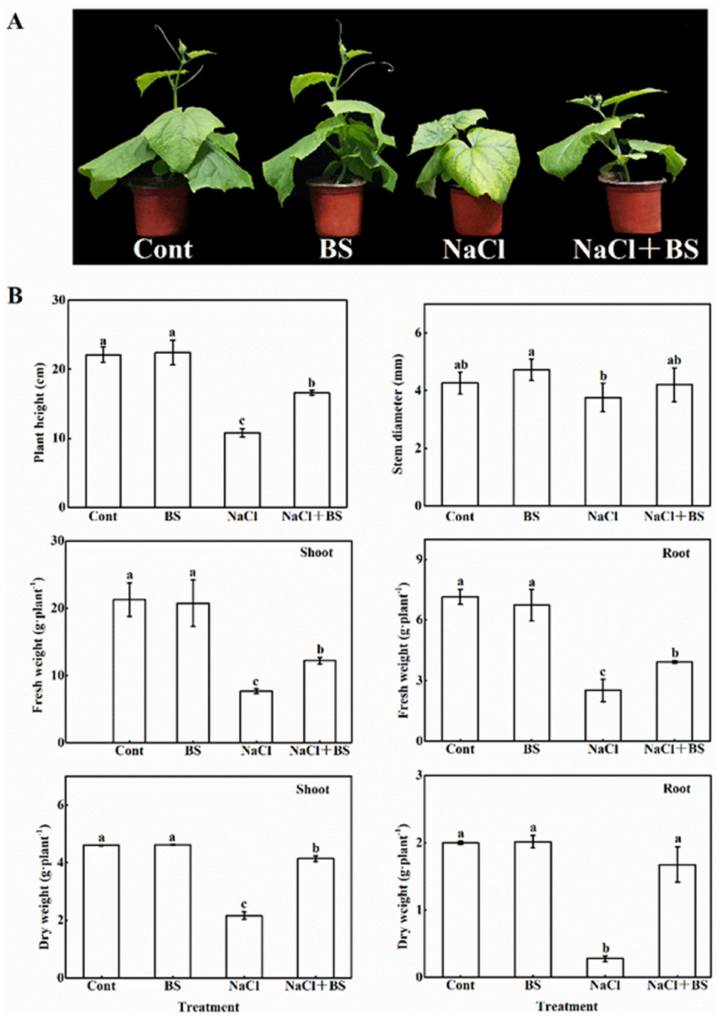
Figure 2. Effects of B. cereus on the phenotype ( A ) and growth ( B ) of cucumber seedlings under salt stress. Bars represent standard errors. Different letters indicate a significant difference in the same parameter between treatments at p <